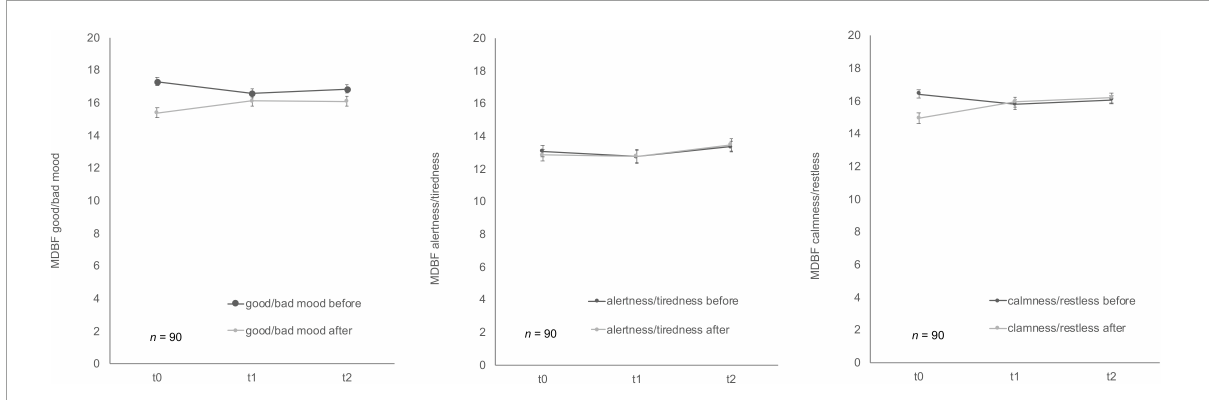
FIGURE5 Stress response of multidimensional mood state questionnaire (MDBF) before and after stress exposure during Trier Social Stress Test for groups (TSST-G) for the three measurement points (t0, t1, t2). Values are means ( ±